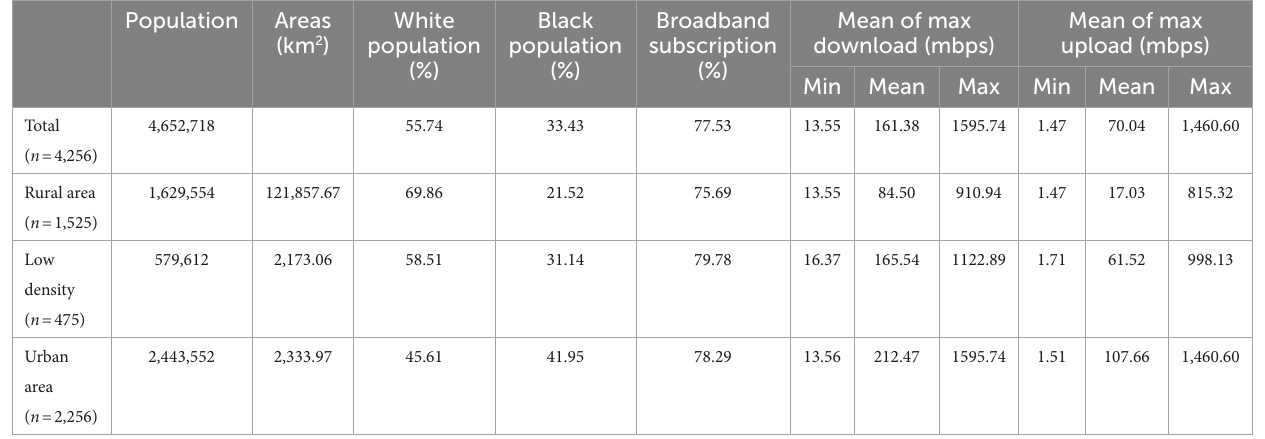
TABLE 1 Demography and broadband access by urbanicity in